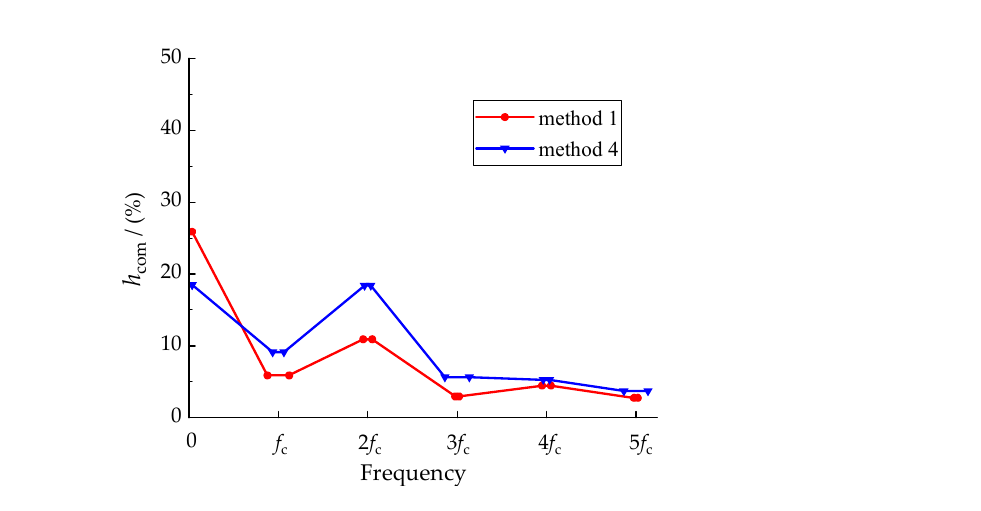
Figure 12. Maximum peak values of common-mode components at different frequency bands.